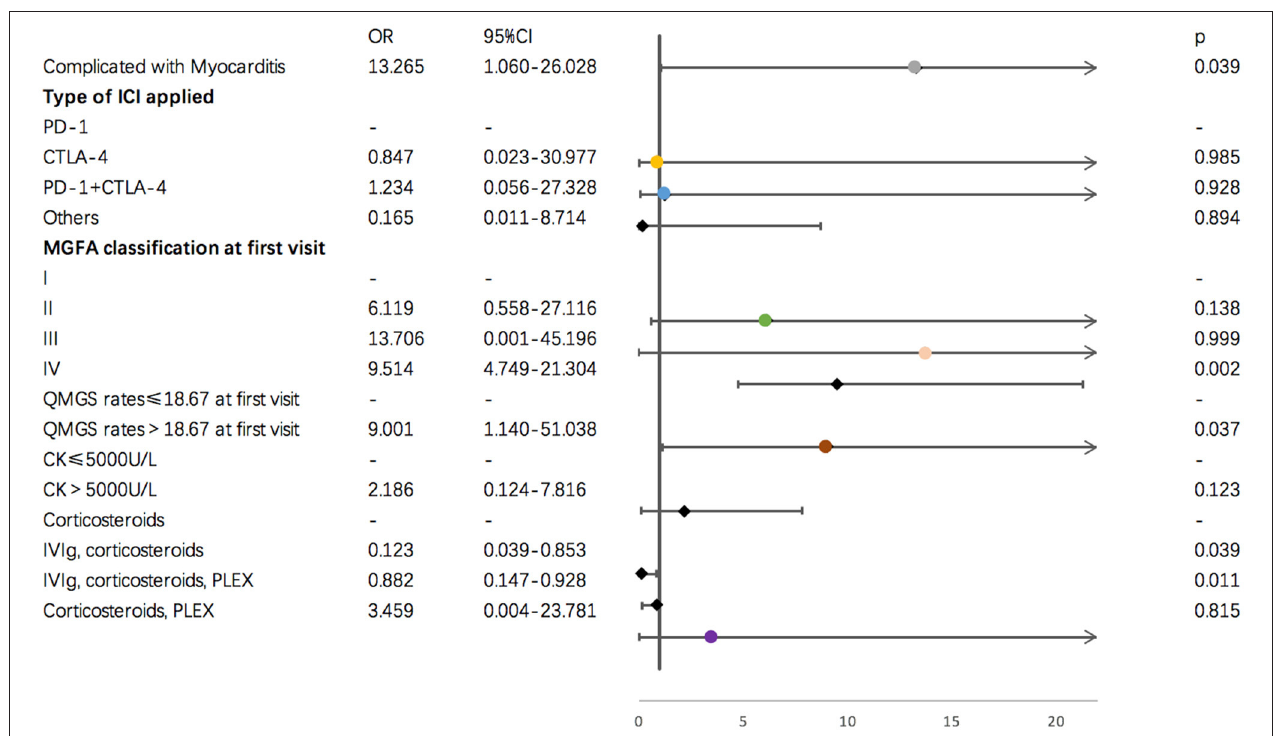
FIGURE 3 | Results of multi-variate binary logistic regression for demographic and clinical factors and irMG